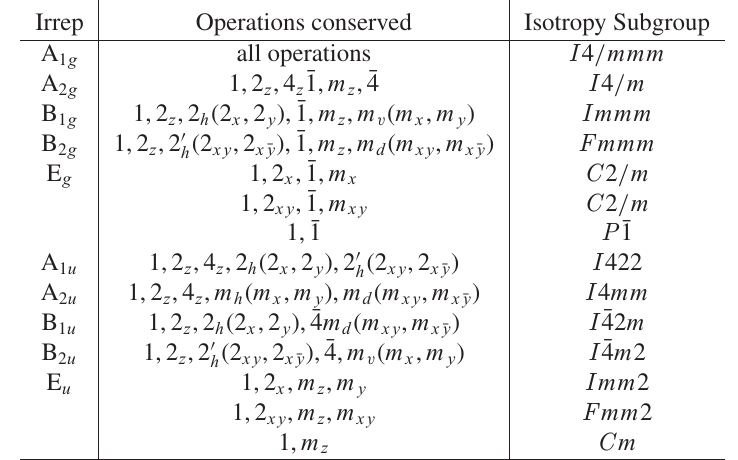
Figure 1. Character table of the irreps of the point group 4 /mmm . Table 1. Isotropy subgroups of I 4 /mmm for irreps with k = 0. For 2-dimensional irreps only one of the equivalent possible isotropy subgroups is